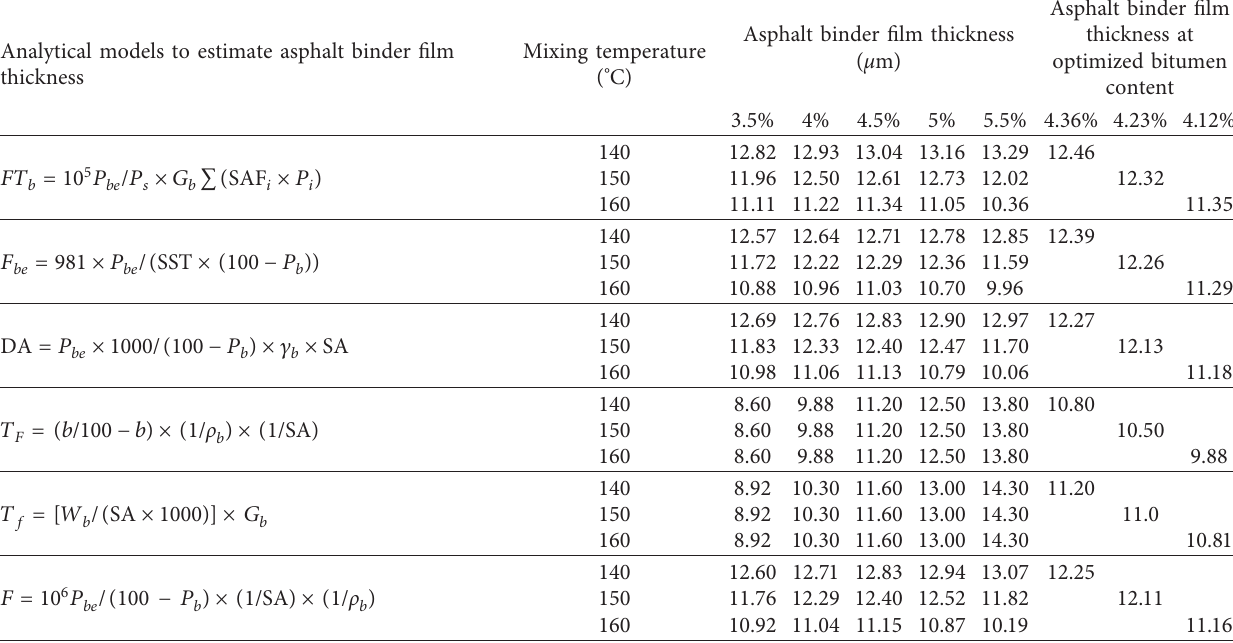
Table 7: Estimated asphalt binder film thicknesses using analytical models.